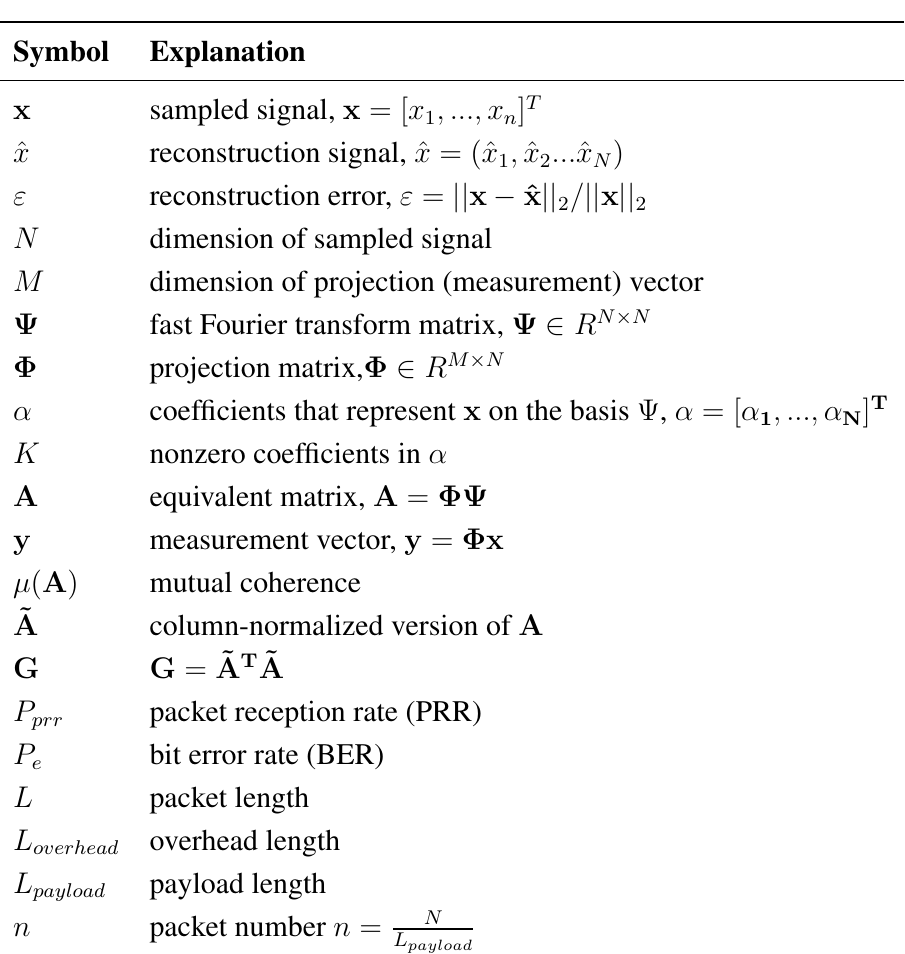
Table 1. Symbols and